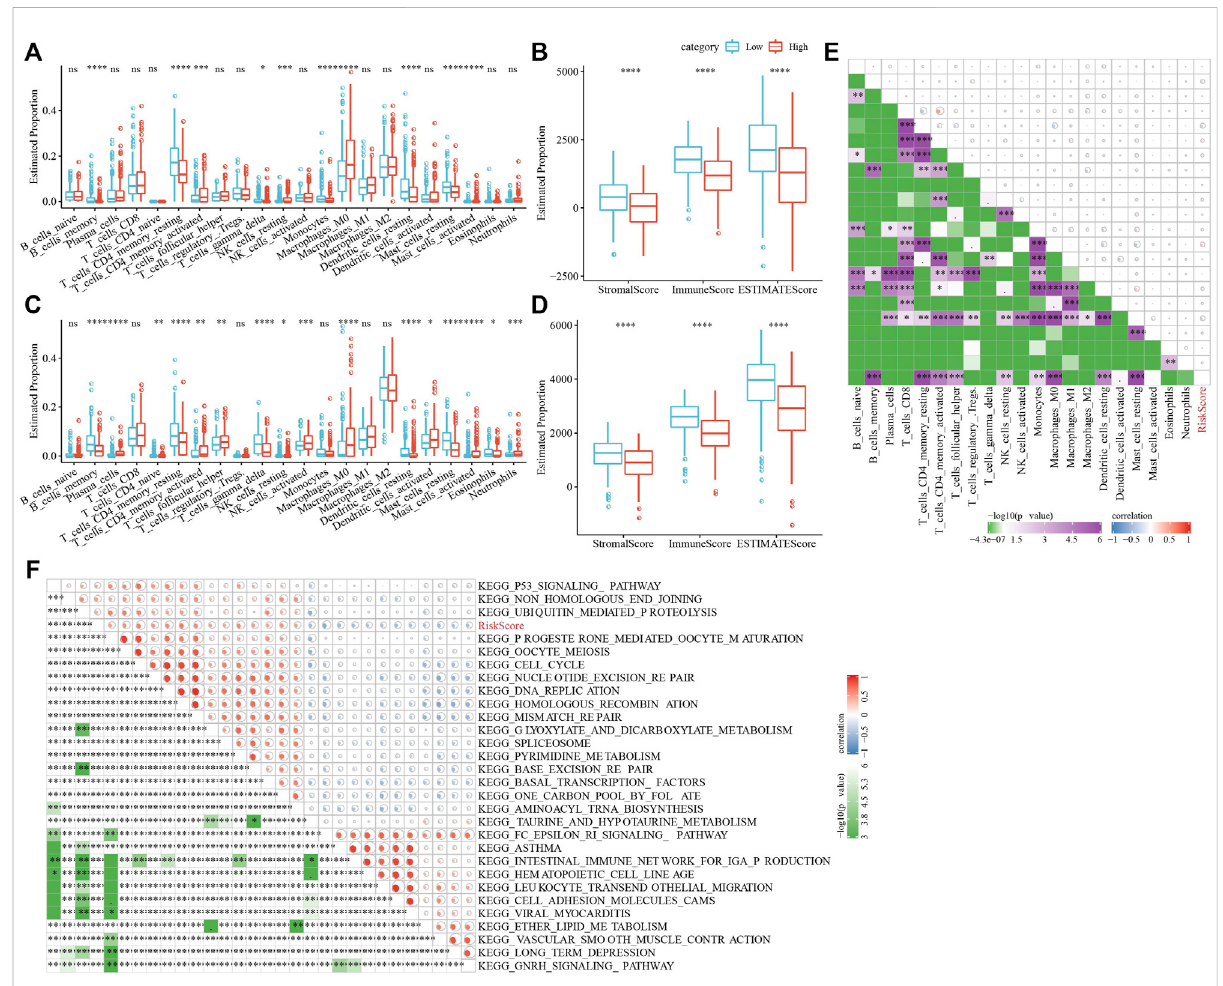
Characteristics of immune/pathways among the RS groups. (A) Proportion of immune cells components in TCGA cohort; (B) Proportion of immune cells components calculated by ESTIMATE software in TCGA cohort; (C) Proportion of immune cells components in TCGA cohort; (D) Proportion of immune cells components calculated by ESTIMATE software in TCGA cohort; (E) Correlation analysis between 22 immune cell components andRS inTCGA cohort; (F) The results ofcorrelation analysis betweenKEGG pathway and RS whose correlation with RS